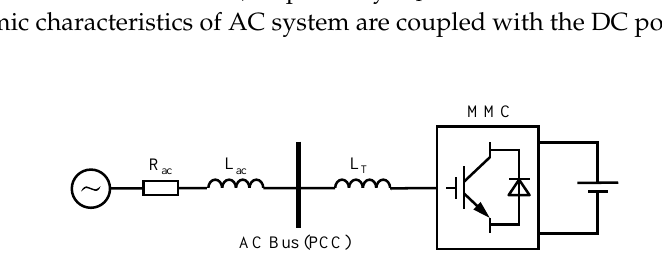
Figure 6. Equivalent circuit of AC System.